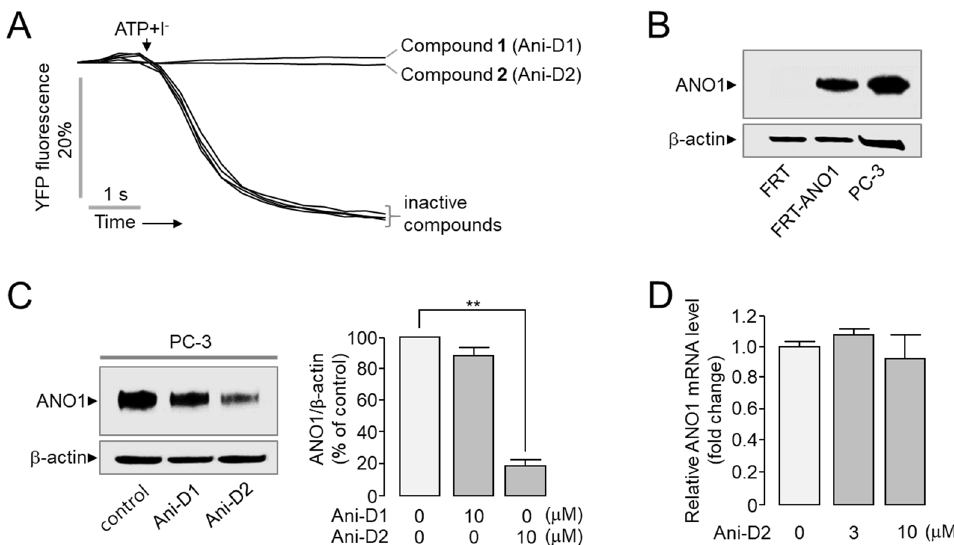
Figure 3. Identification of novel ANO1 inhibitor, Ani-D2. ( A ) Inhibitory effect of compounds 1 – 6 on ANO1 activity was measured in FRT cells expressing human ANO1 and a mutant YFP. The cells were pretreated with compounds 1 (Ani-D1) and 2 (Ani-D2) at 25 μ M for 20 min. ANO1 was activated by 100 ATP μ M. ( B ) Representative Western blot analysis of ANO1 in FRT, FRT-ANO1, and PC-3 cells (two independent experiments performed). ANO1 protein expression was measured in FRT, FRT-ANO1, and PC-3 cells. ( C ) Effect of Ani-D1 and Ani-D2 on the protein expression levels of ANO1 in PC-3 cells. PC-3 cells were treated with 10 μ M of Ani-D1 and Ani-D2 for 24 h. (Right) Summary of band intensity. The ANO1 band intensity was normalized to β -actin (mean ± S.E., n = 3). ( D ) ANO1 mRNA expression levels were determined by real-time PCR in PC-3 cells treated with Ani-D2 for 24 h (mean ± S.E., n = 3). ** p < 0.01.